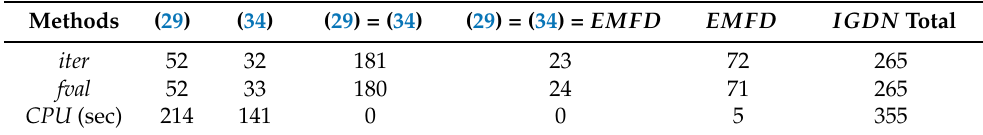
Table 1. IGDN-EMFD comparisons.